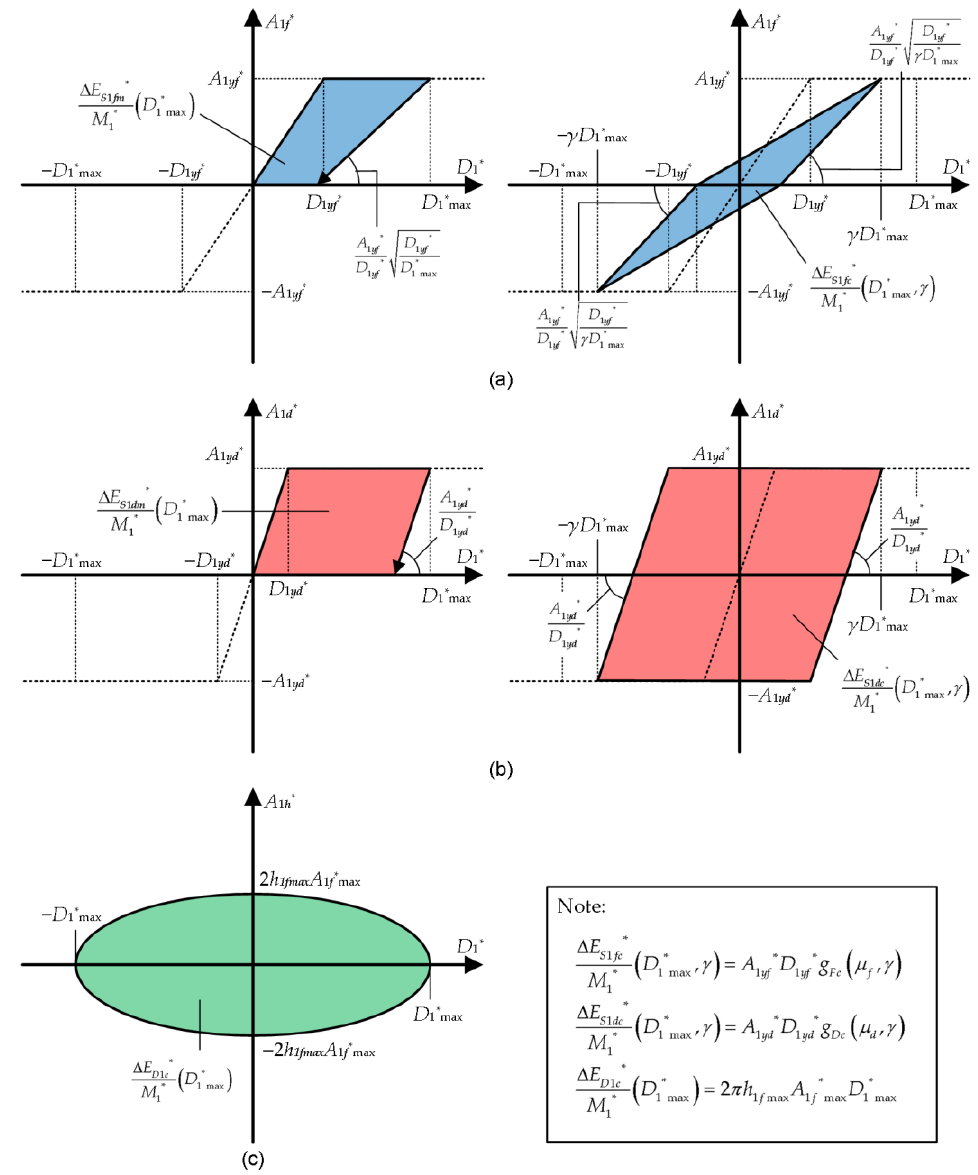
Figure A3. Simplified models for calculation of the cumulative dissipated energy during a whole seismic event: ( a ) contribution of RC MRFs; ( b ) contribution of steel damper columns; ( c ) contribution of viscous damping.